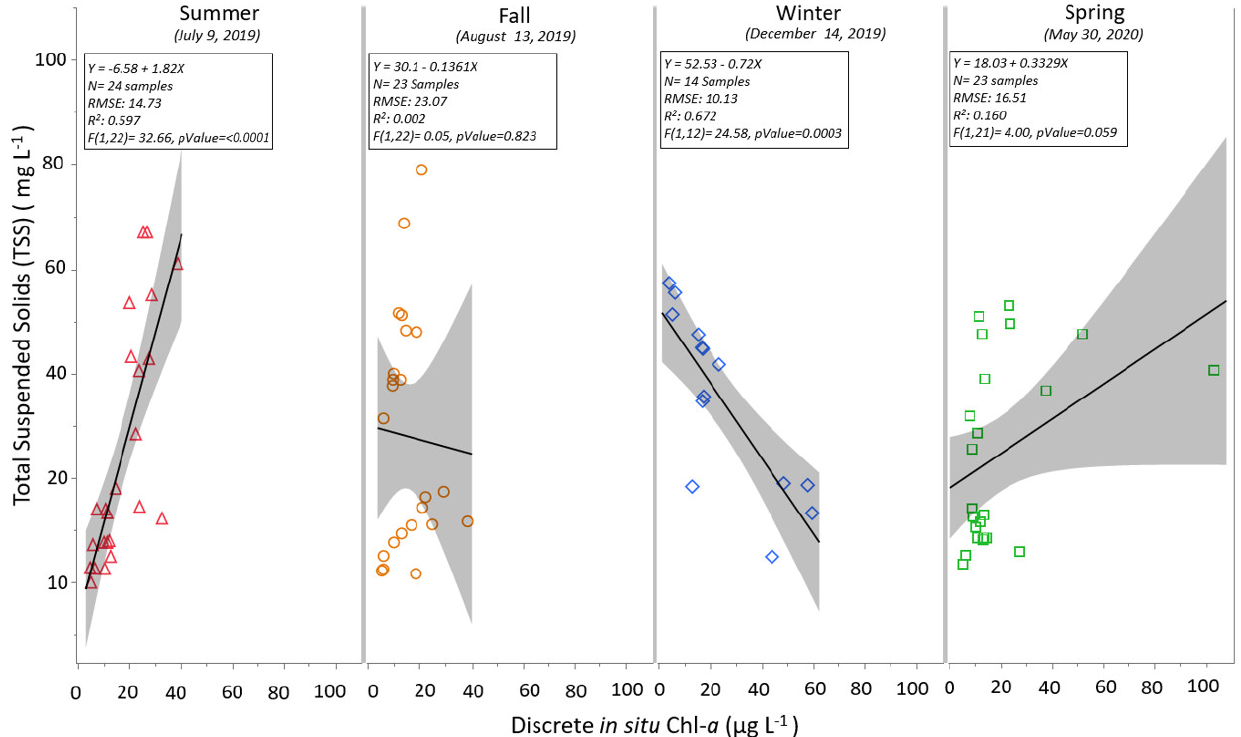
Figure 5. Seasonal correlation between TSS and EPA Chl- a from 84 discrete samples collected across the BB complex. The solid line shows the best linear fit; the grey band along the regression line shows the 95% confidence interval.